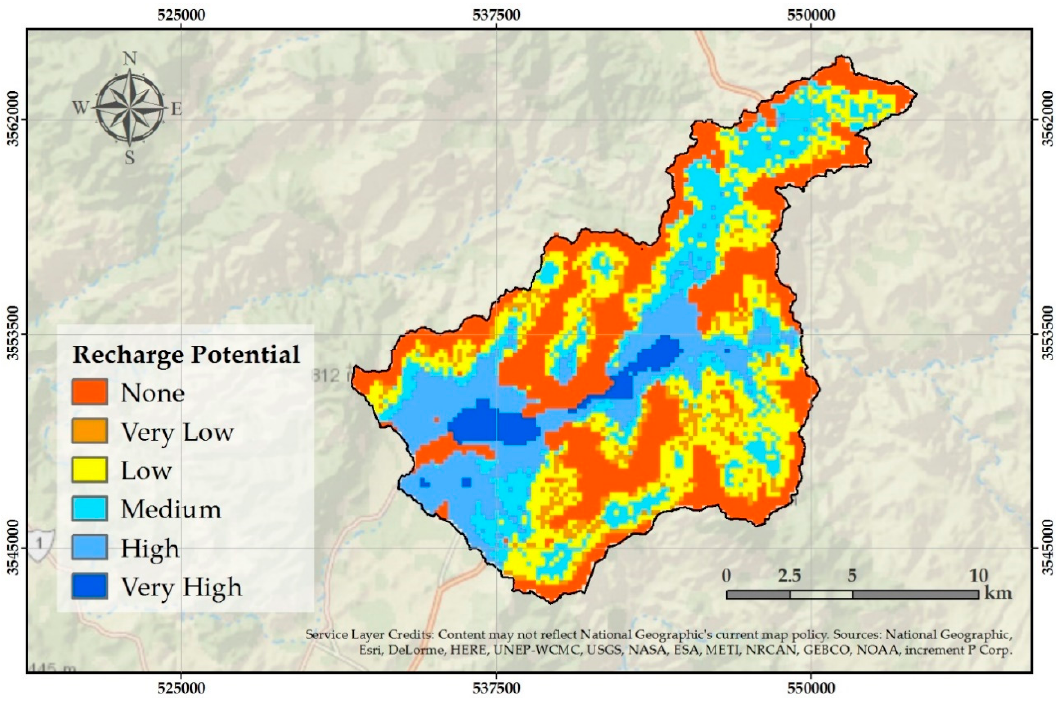
Figure 7. Map of potential recharge areas obtained in GIS. Table 4. Areas and percentages of the spatial distribution per type of recharge zone. Recharge